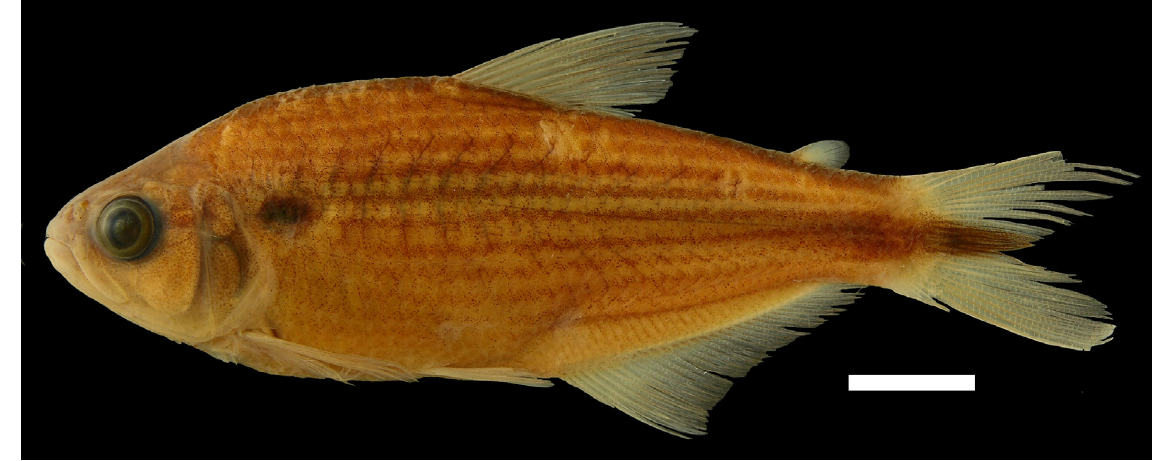
Fig. 10. Astyanax superbus Myers, 1942, 70.4 mm SL, Guache River, Garabote, Portuguesa state, Venezuela (MCNG 36349). Scale bar =